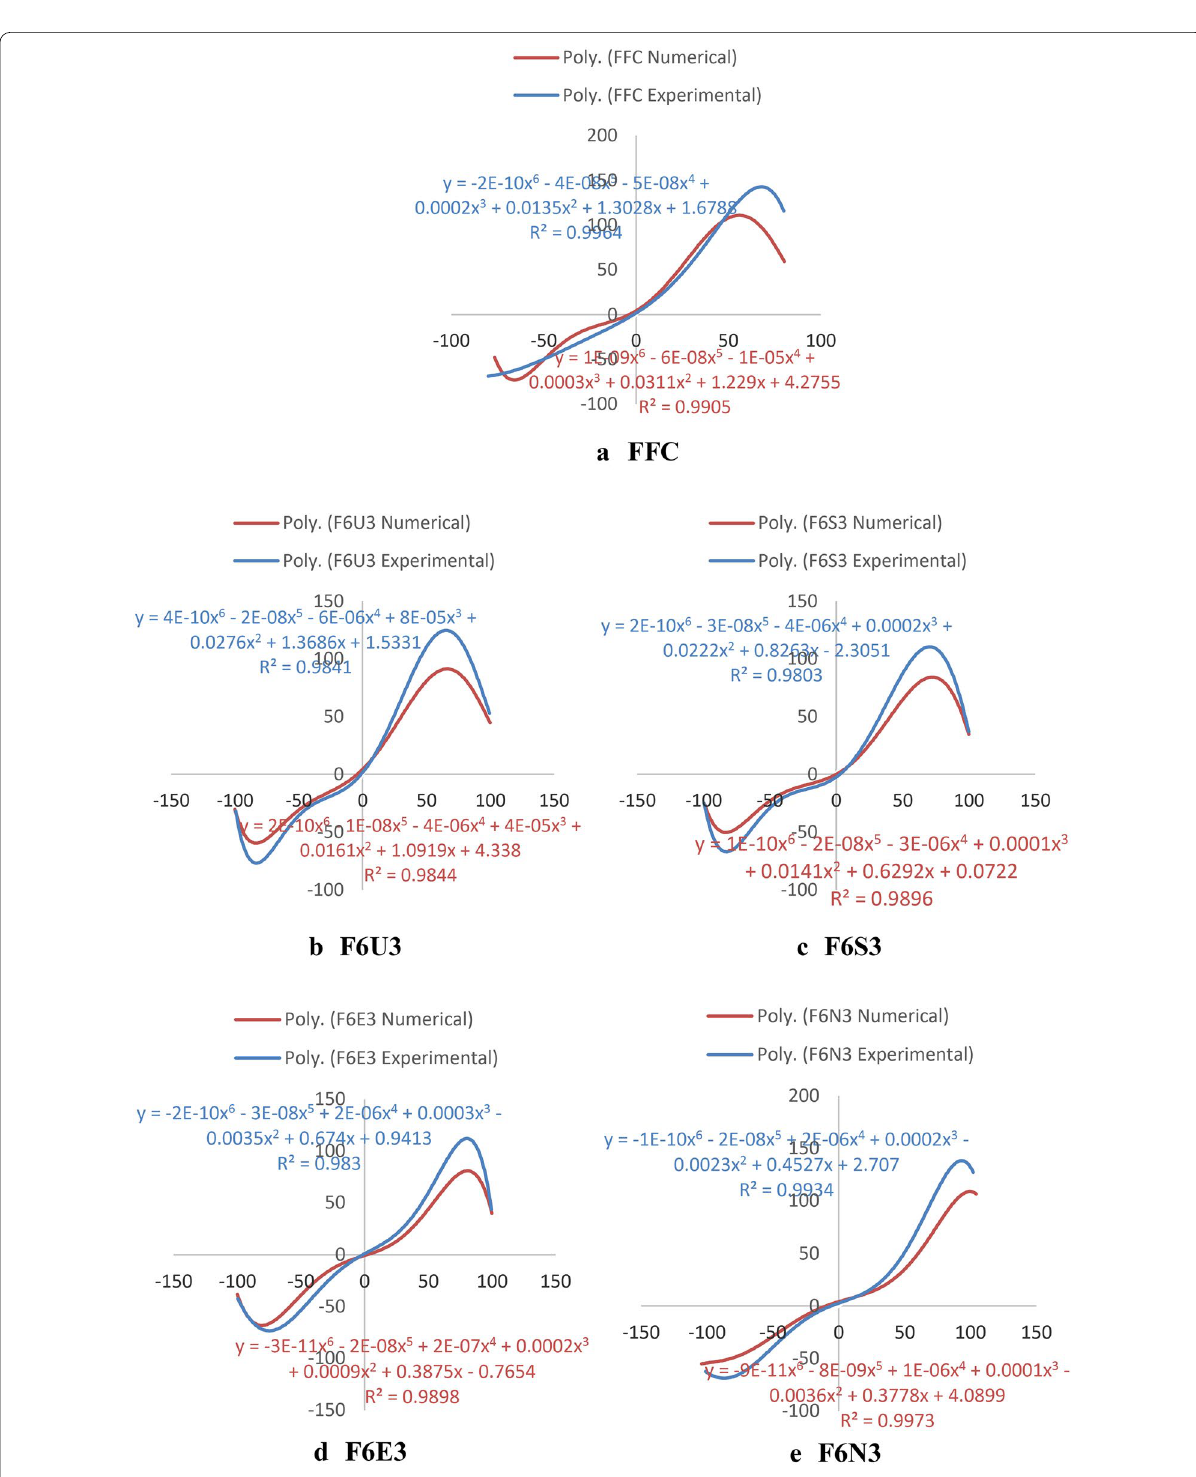
Fig. 23 Numerical vs experimental envelope